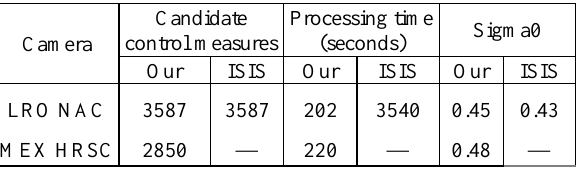
Table 5. The overall bundle adjustment results and processing time of tie points extraction.